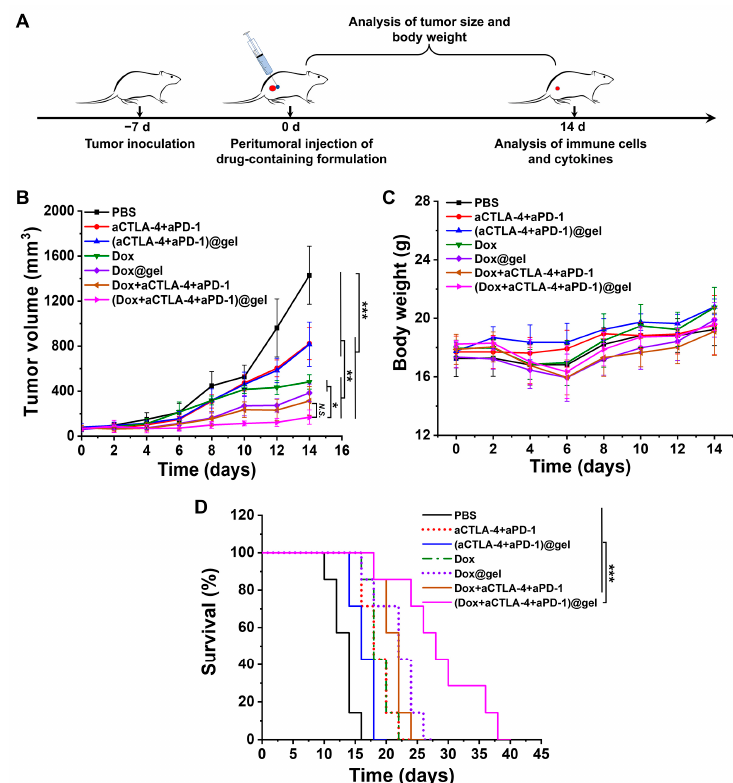
Figure 3. ( A ) Schematic illustration of localized treatment of melanoma-bearing mice with peritumoral injection of drug-containing systems. ( B ) Tumor volume curves during therapy ( n = 5). ( C ) Changes of the body weight of mice during therapy ( n = 5). ( D ) Survival periods of various experiment groups ( n = 7). (* p < 0.05, ** p < 0.01, and *** p < 0.001) Additionally, it was found that all the local treatments resulted in no obvious effect on the body weight in the mice (Figure 3C), indicating a reduced systemic side effect. After treatment for 14 days, the main organs of the mice, such as the heart, liver, spleen, lung and kidney, were taken and stained with H&E staining. Observation and pathological analysis were carried out under a microscope. As shown in Figure 4, no obvious patho- logical changes were found in any of the groups. This confirmed that the treatments with localized injection of drug-containing formulations showed no obvious toxic side effects to normal organs. Compared to systemic administration, the local and sustained release of Dox and ICB antibodies at tumor sites can markedly reduce the blood drug concentra- tion and drug distribution in normal tissues [29]. Thus, low systemic toxicity was ob- served for the local treatments.